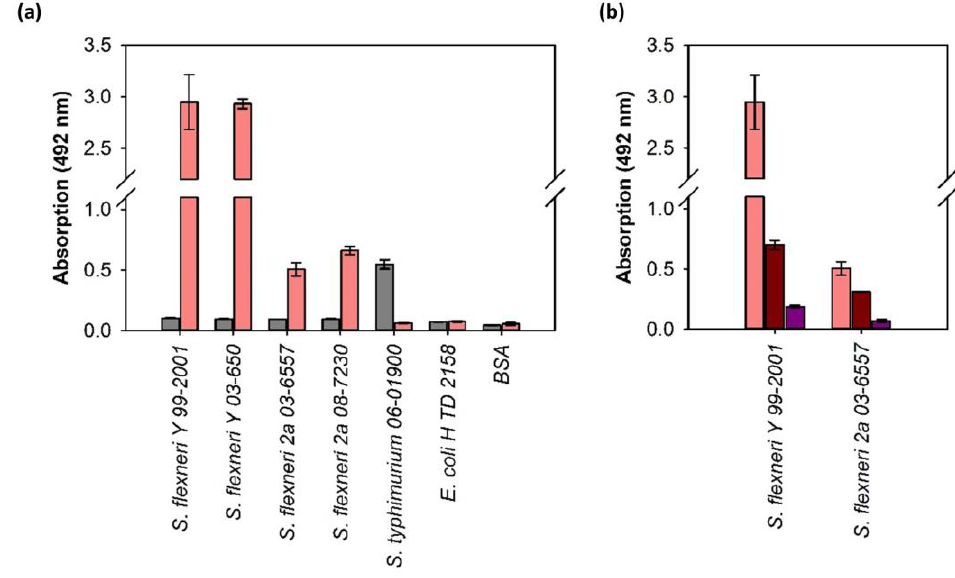
Figure 3. ELITA (ELISA-like tailspike adsorption assay). ( a ) Strep-tagged TSP probes of StrepII-Sf6 (pink) and StrepII-P22 (gray) were used for analysis of the indicated Shigella and Salmonella strains. E. coli and 1 mg/mL BSA were used as a negative control for both proteins. ( b ) To control the O-antigen specificity of the detection process, enzymatically active Sf6TSP wt (30 nM) was added to immobilized bacteria (dark red) before detection with StrepII-Sf6TSP. To compete with bacteria-associated O-antigen, an S. flexneri Y O-polysaccharide preparation (50 µ g mL − 1 Sf Y PS) was co-incubated with the StrepII-Sf6TSP (violet). For comparison, pink bars reproduced from (a) show StrepII-Sf6TSP detection of S. flexneri Y and 2a without further treatment (pink). Error bars show standard deviations from three sample